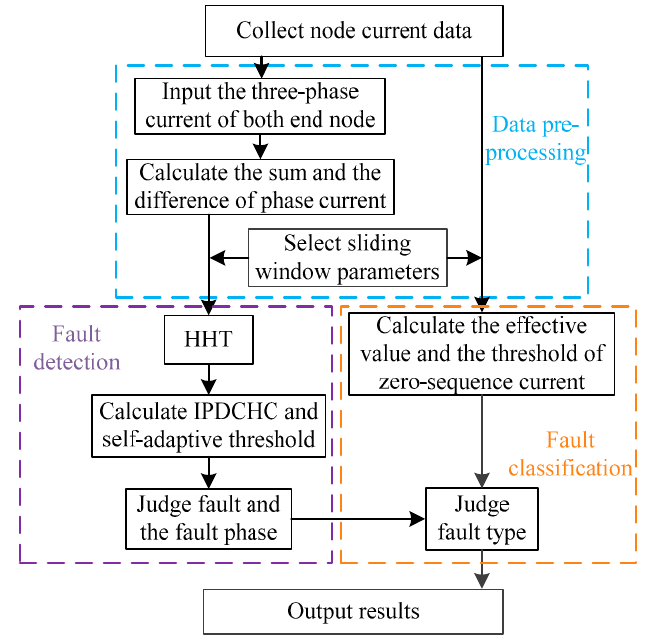
Figure 4. Overall flow chart.